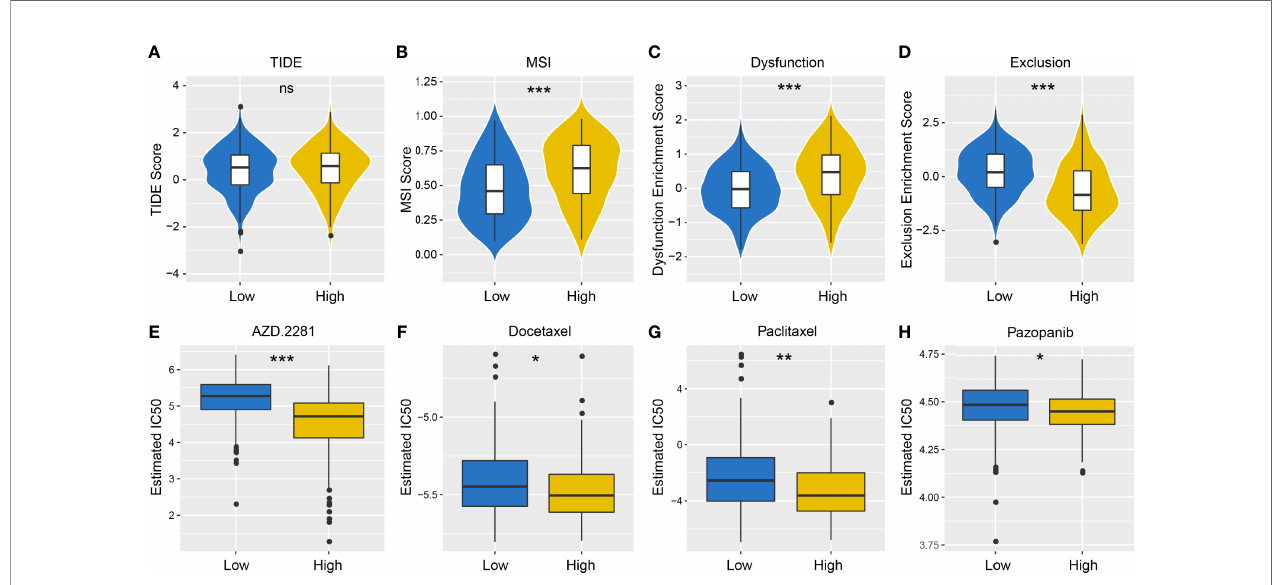
FIGURE 6 | Differences in the sensitivity of immunotherapy and chemotherapy between different PD-L1 expression groups. TIDE (A) , MSI (B) , T cell Dysfunction (C) and T cell Exclusion (D) scores in PD-L1 high and PD-L1 low Groups (NS: not signi fi cant; * P < 0.05; ** P < 0.01; *** P < 0.001). Sensitivity to olaparib (AZD. 2281) (E) , docetaxel (F) , paclitaxel (G) and pazopanib (H) in PD-L1 high and PD-L1 low Groups (NS: not signi fi cant; * P < 0.05; ** P < 0.01; *** P <